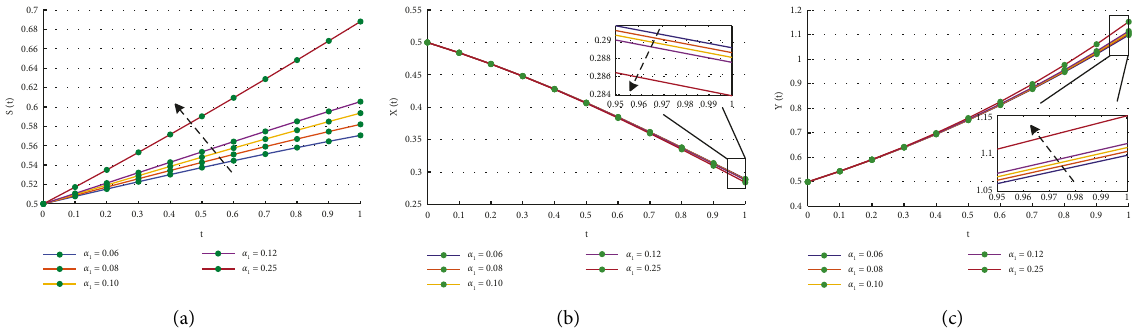
Figure 6: Comparison between solutions obtained by the LeNN-WOA-NM algorithm under the influence of variations in the intrinsic growth rate of local prey on population densities of the prey-predator model. (a) Approximate solutions for population density of local prey. (b) Approximate solutions for population density of immigrant prey. (c) Approximate solutions for population density of the predator.